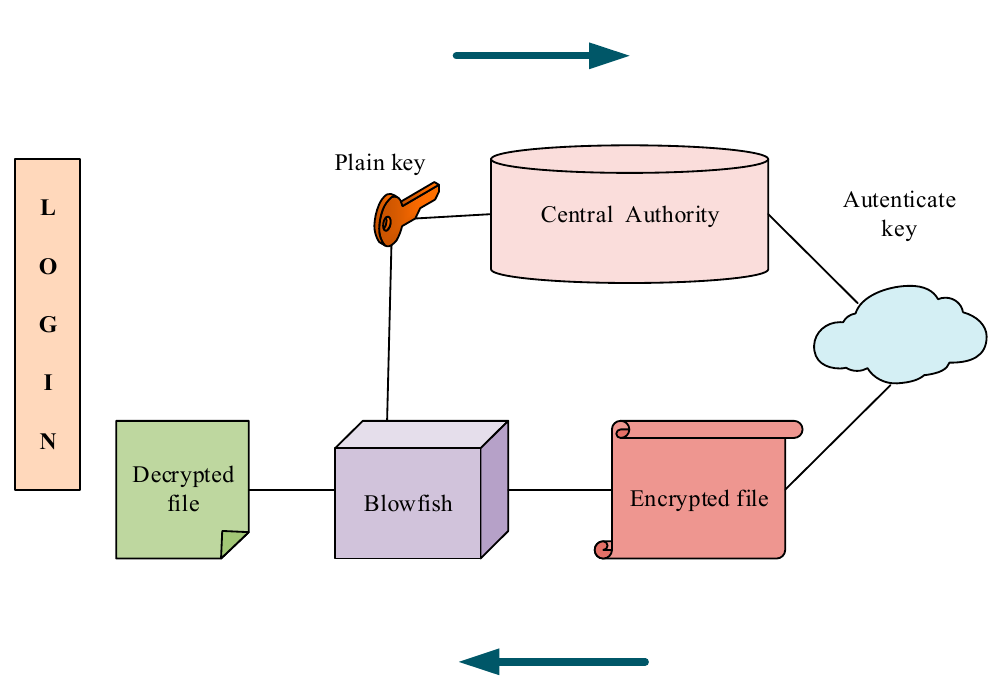
Figure 4. Data user side (decryption process).